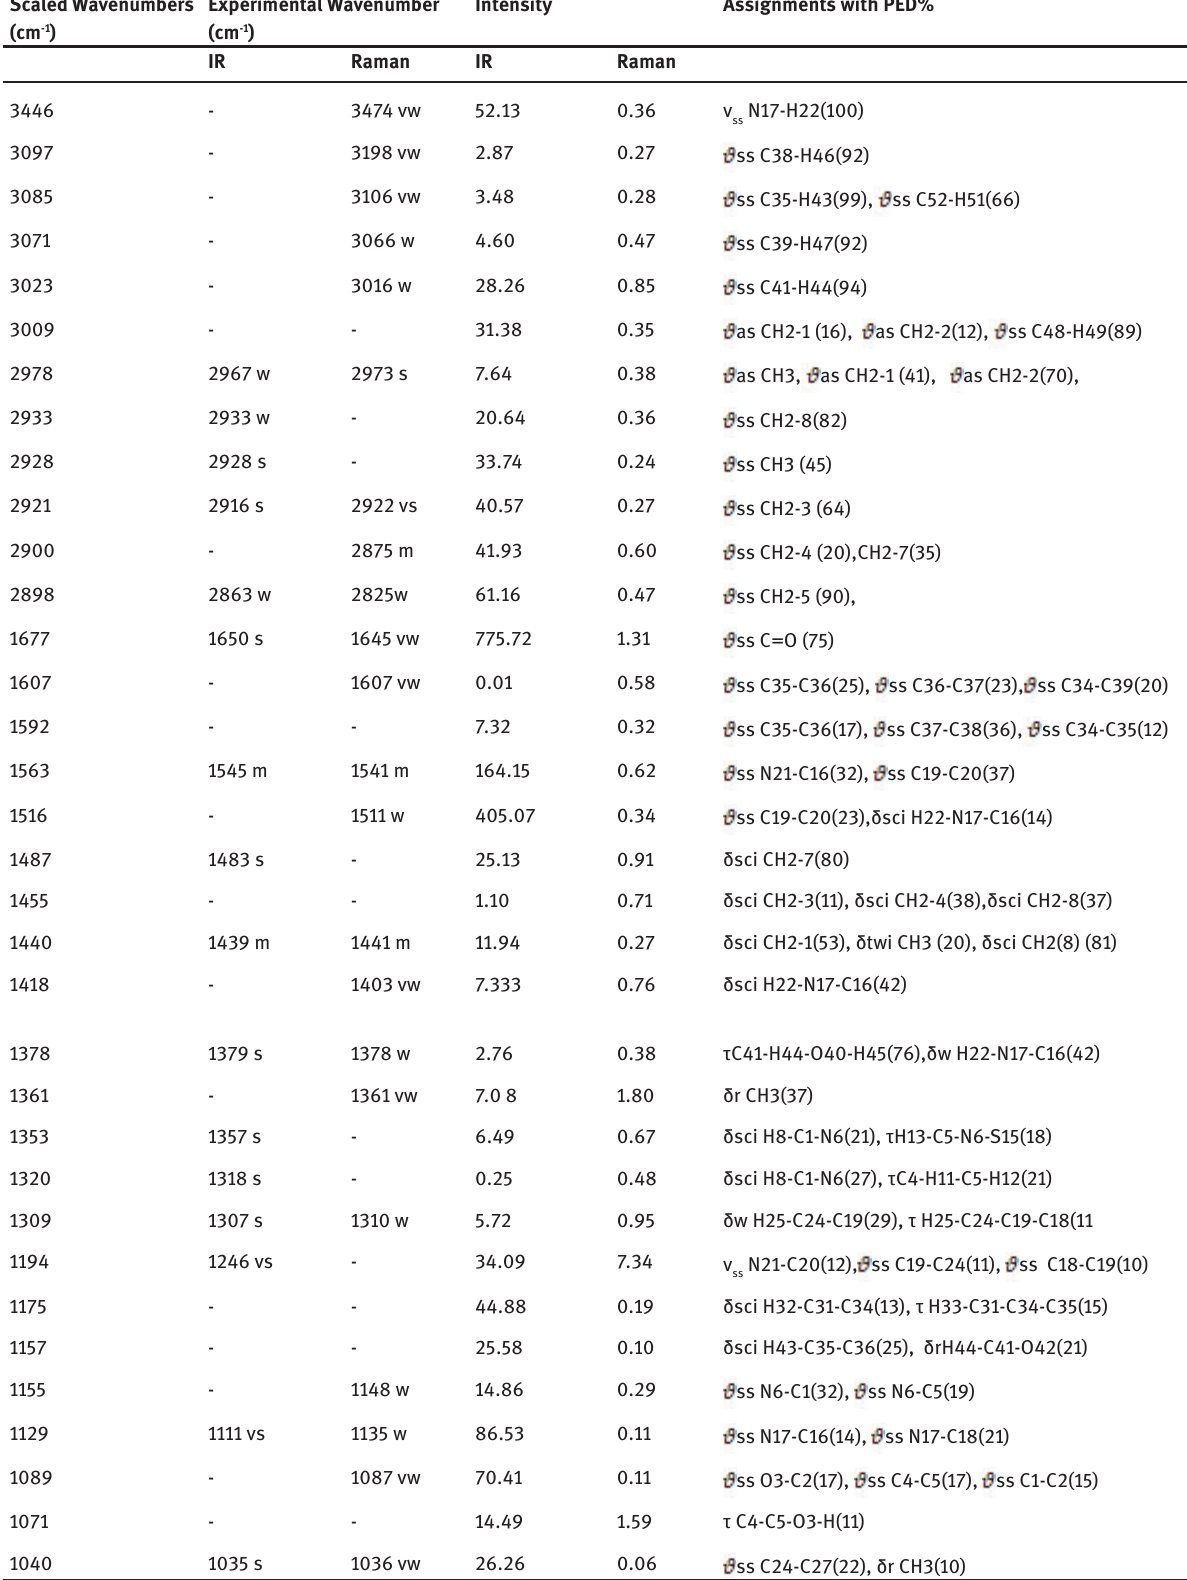
Table 3: The selected vibrational wavenumbers (cm −1 ), measured infrared and Raman band positions (cm -1 ), and their tentative assignment. Scaled Wavenumbers (cm -1